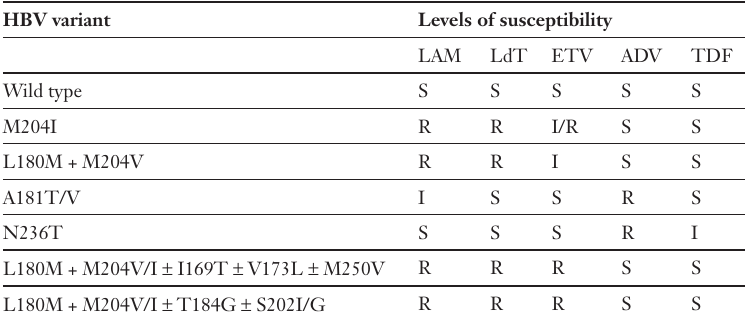
Viral mutations and cross-resistances to the different anti-viral agents (S: sensitive; I: intermediate; R: resistant). Adapted from [1]. HBV variant